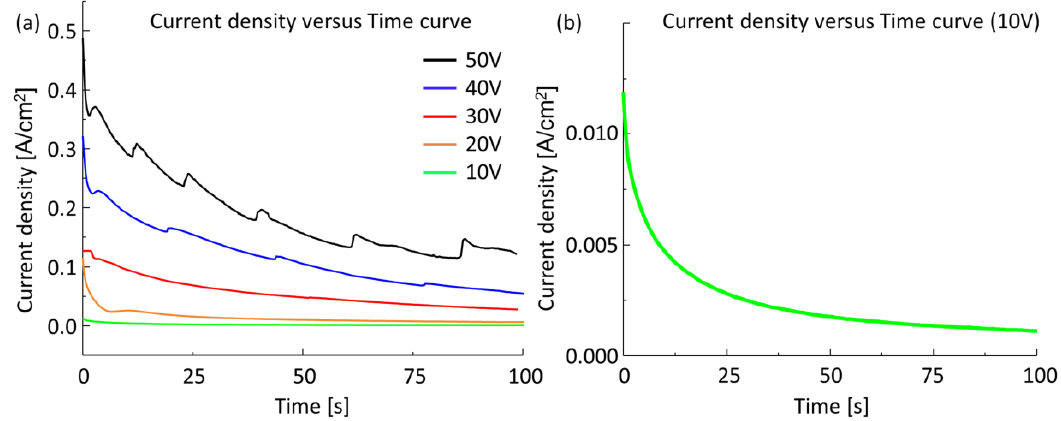
Figure 2. Current density versus time curve for Si wafer during the electrochemical oxidation (ECO) process ( a ) 10 V, 20 V, 30 V, 40 V, 50 V ( b ) Enlarged curve for 10 V.